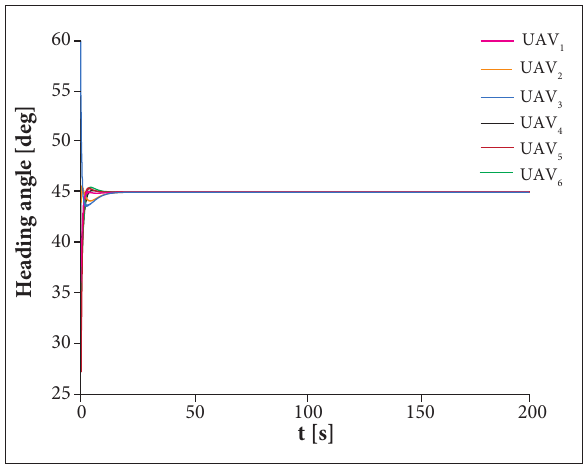
figure 10. Time histories of the heading